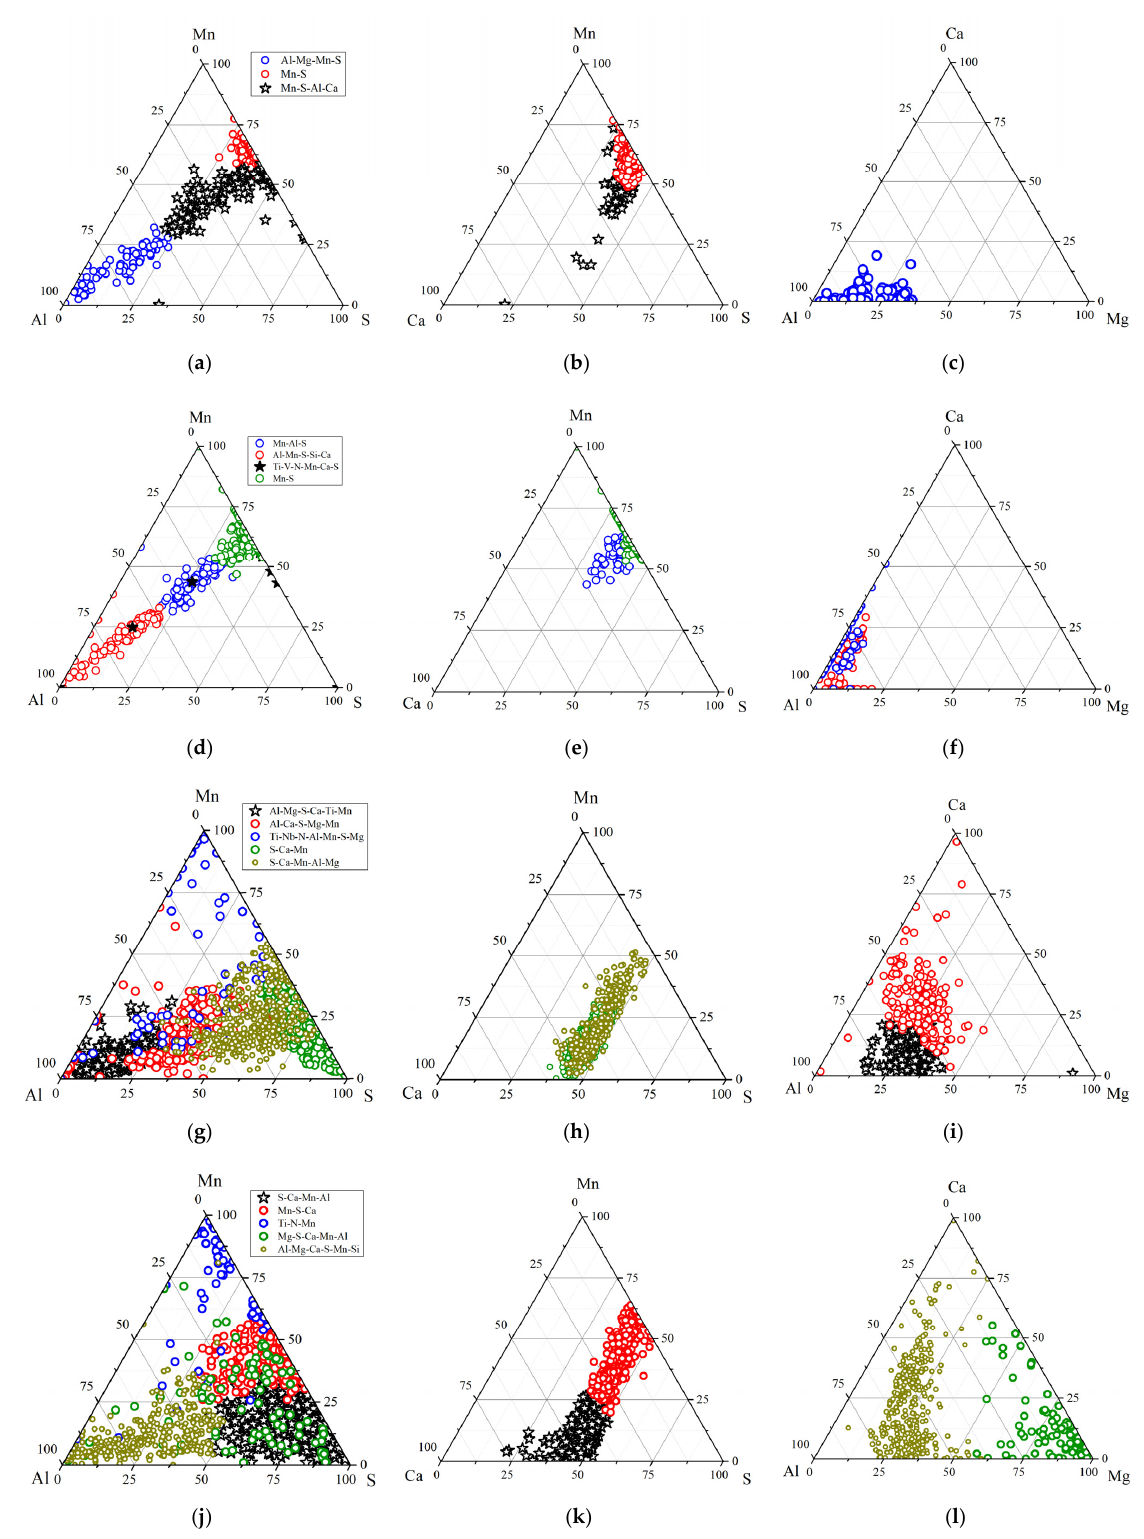
Figure 3. Chemical compositions of nonmetallic inclusions in the studied steels, presented on ternary diagrams in the coordinates of the elements most often found in NMi: ( a , b , c ) 9MnSi5 , ( d , e , f ) B; ( g , h , i ) X70; ( j , k , l ) 30CrMnSi.